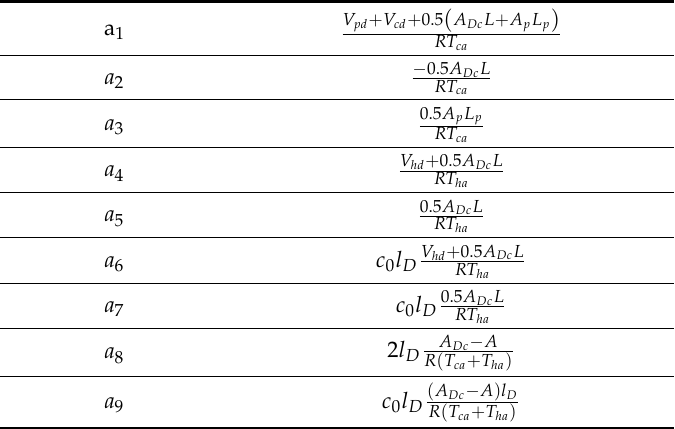
Table A2. The coefficient of Equation (10).